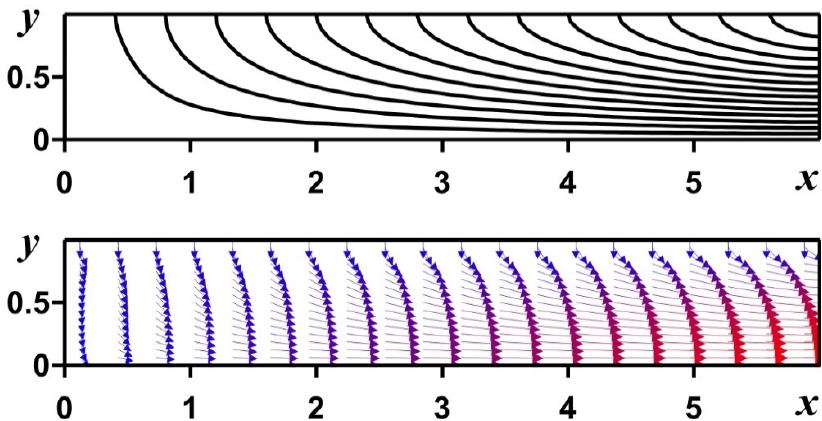
Figure 12. Streamlines and velocity field for Re = 5 and α = 1.